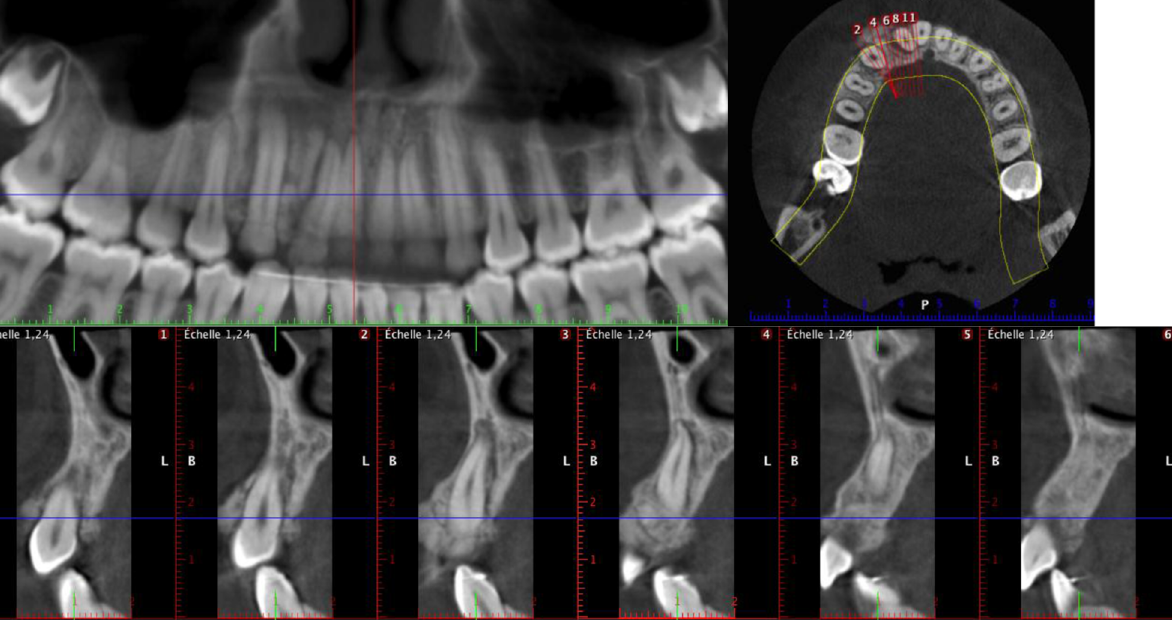
Fig. 2. Heterogeneous image between 12 and 13 with vestibular and palatal involvement and periosteal reaction.